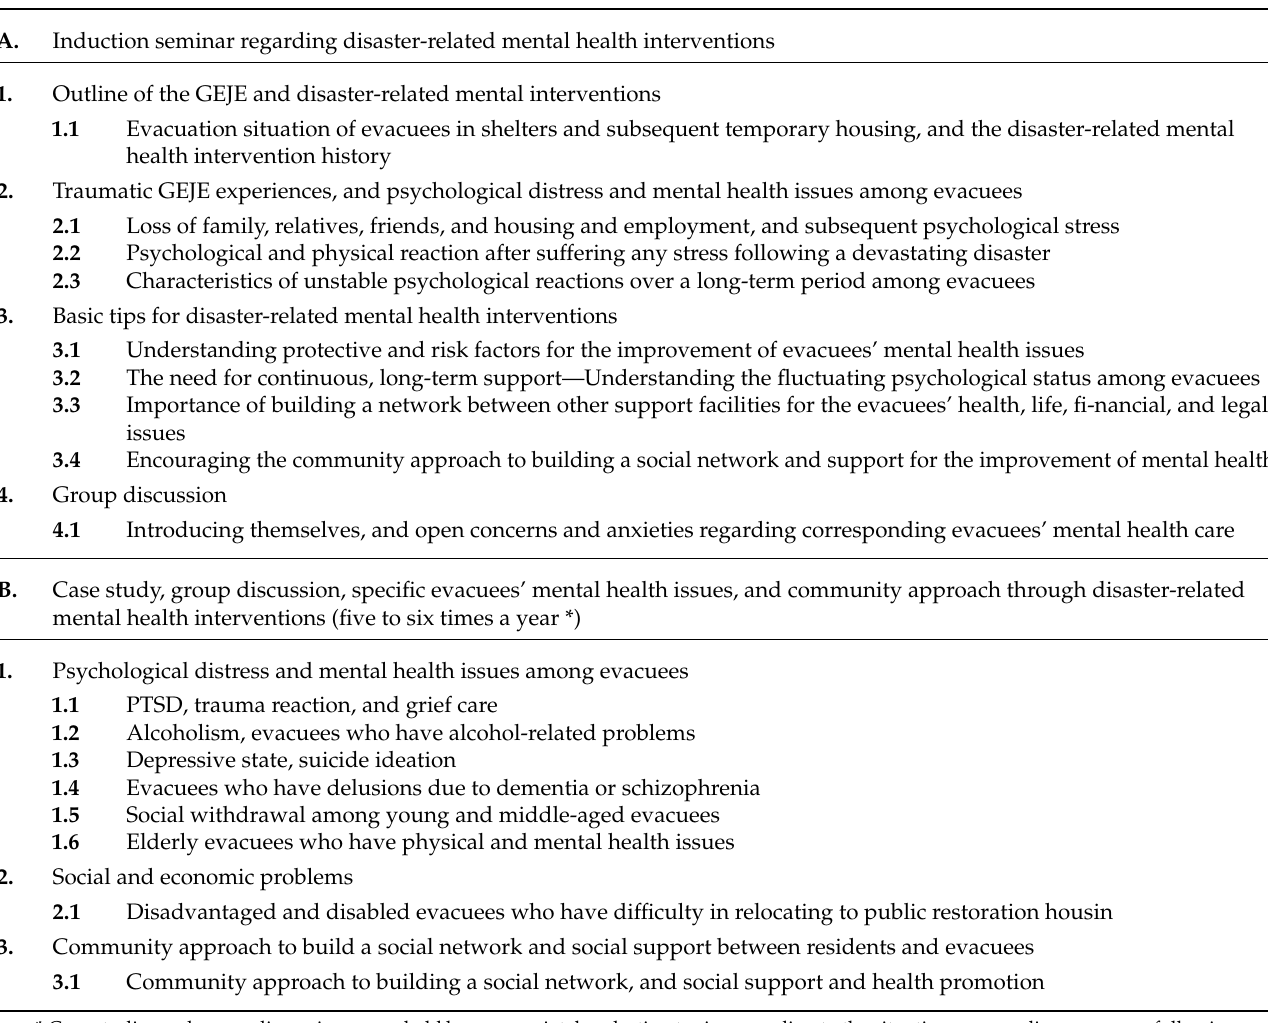
Table 1. Pre-COVID-19 human resource development training seminar series focused on disaster-related mental health